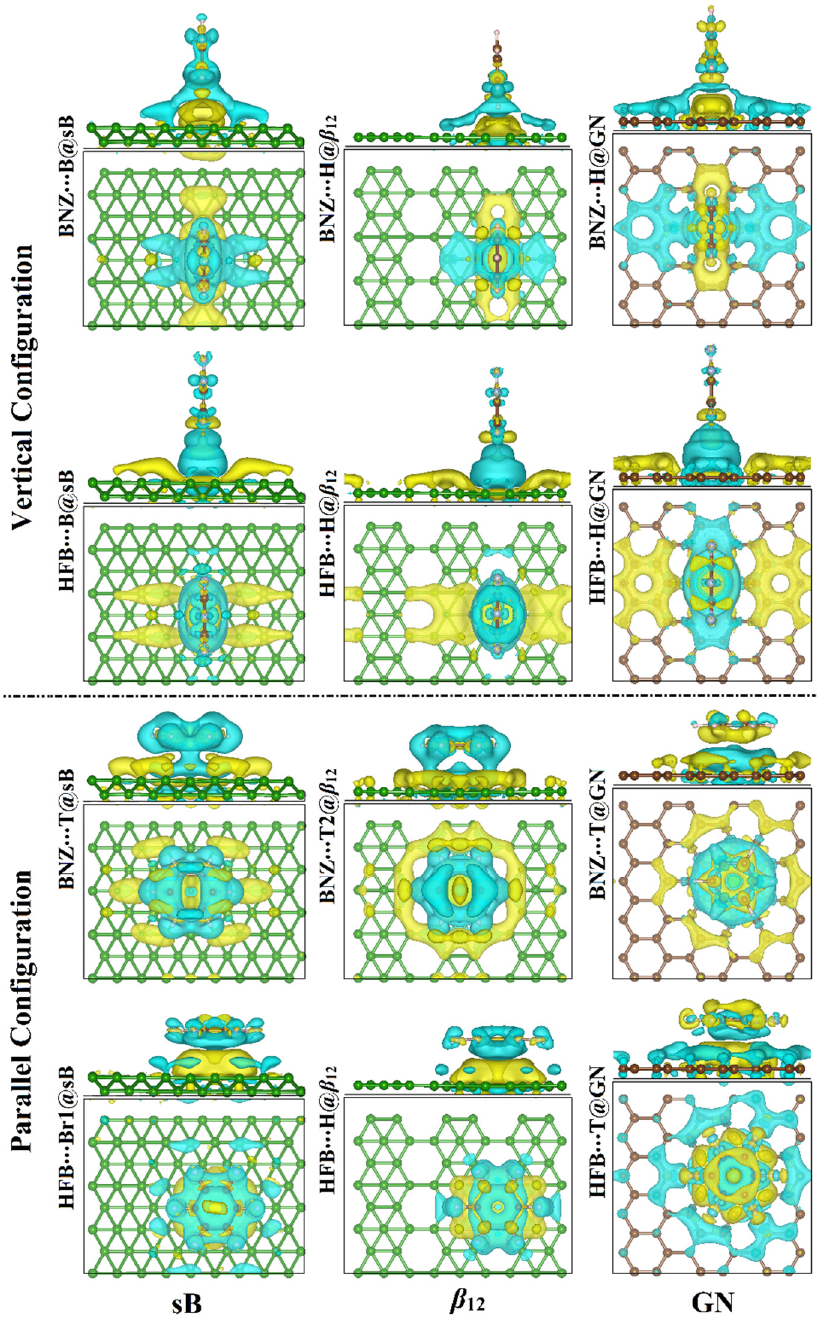
Figure 4. Charge density difference maps of the relaxed structures of the vertical and parallel con- figurations of the π -system ∙∙∙ 2D sheet complexes where π -system = BNZ/HFB and the 2D sheet = sB/ β 12 /GN at the most energetically favorable adsorption sites. Cyan and yellow colors represent the charge accumulation (negative) and depletion (positive), respectively. Green, pink, Gray, and brown balls refer to boron, hydrogen, fluorine, and carbon atoms.